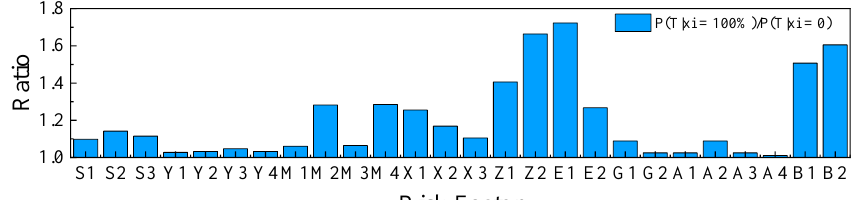
Figure 10. ratio of risk factors. Figure 10. Ratio of risk factors.